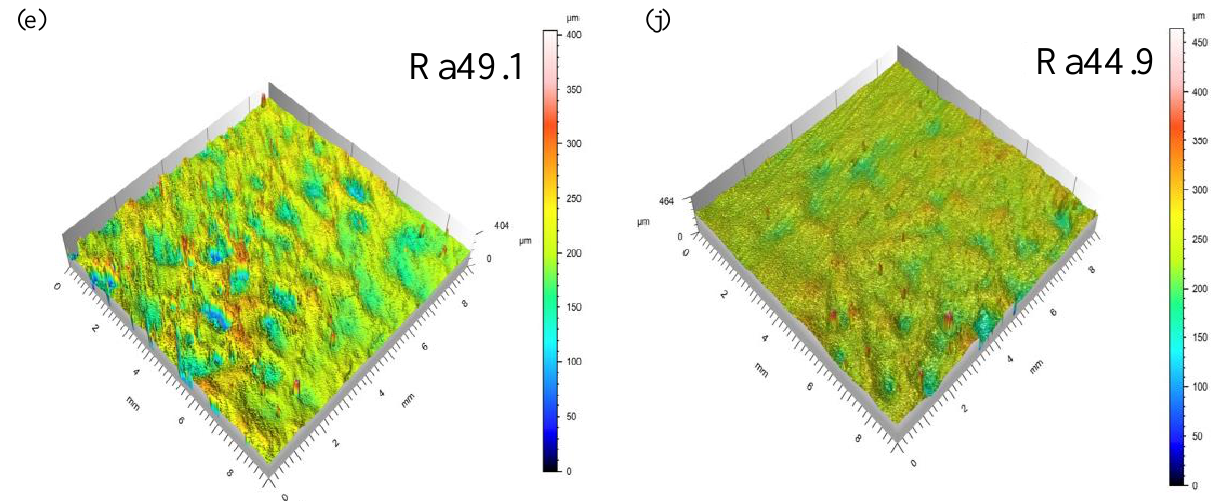
Figure 8. The surface roughness of the specimen. ( a ) 3#; ( b ) 4#; ( c ) 5#; ( d ) 6#; ( e ) 7#; ( f ) 12#; ( g ) 13#; ( h ) 14#; ( i ) 15#; ( j ) 9#.